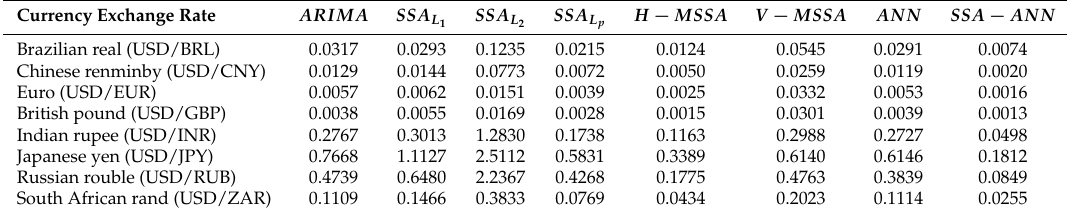
Table 4. Root mean square error for model fit for each of the eight currency exchange rates, considering each of the eight models/algorithms, ARIMA, SSA for the window length and number of eigentriples for reconstruction as defined in Table 3, multivariate SSA for the window length and number of eigentriples for reconstruction as defined in Table 3, ANN, and the hybrid method that combines SSA and